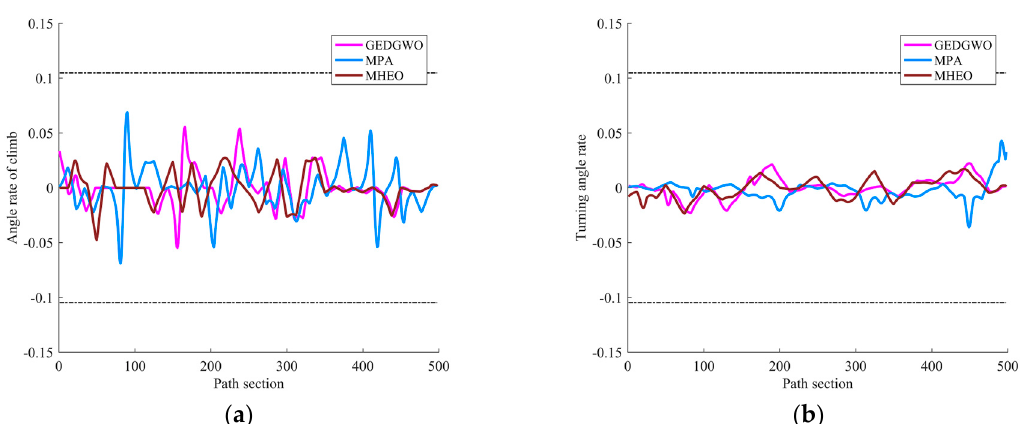
Figure 6. The best path of each algorithm: ( a ) climb angle; ( b ) turn angle.